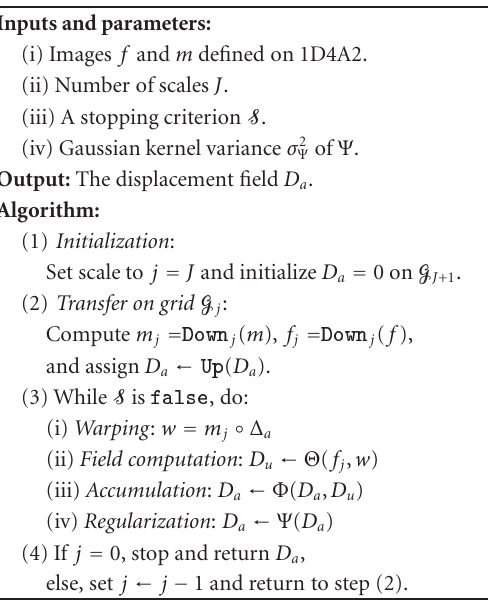
Table 1: Multiscale nonparametric procedure.